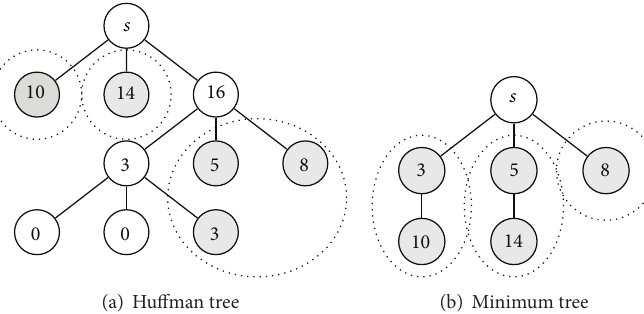
Figure 7: Huffman and Minimum trees for the same peers with selected 𝑅𝑇𝑇 s (values 3, 5, 8, 10, and 14). Members of each group are placed within dotted circles. 𝑡 = 3 .